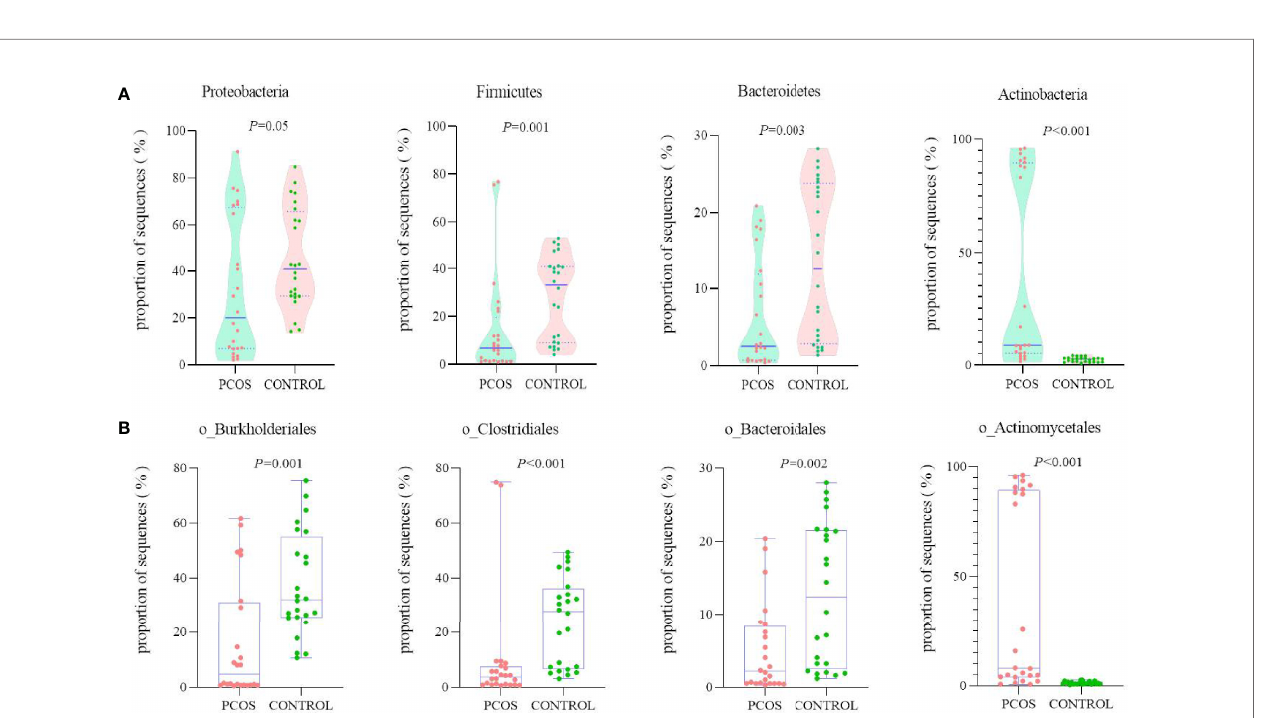
FIGURE 1 | Alpha and beta diversity of two groups. (A) Alpha diversity of two groups using Faith ’ s phylogenetic diversity, Chao1 index, and Observed_OTUs (all p < 0.001). (B) Beta diversity shown by principal coordinates analysis using weighted